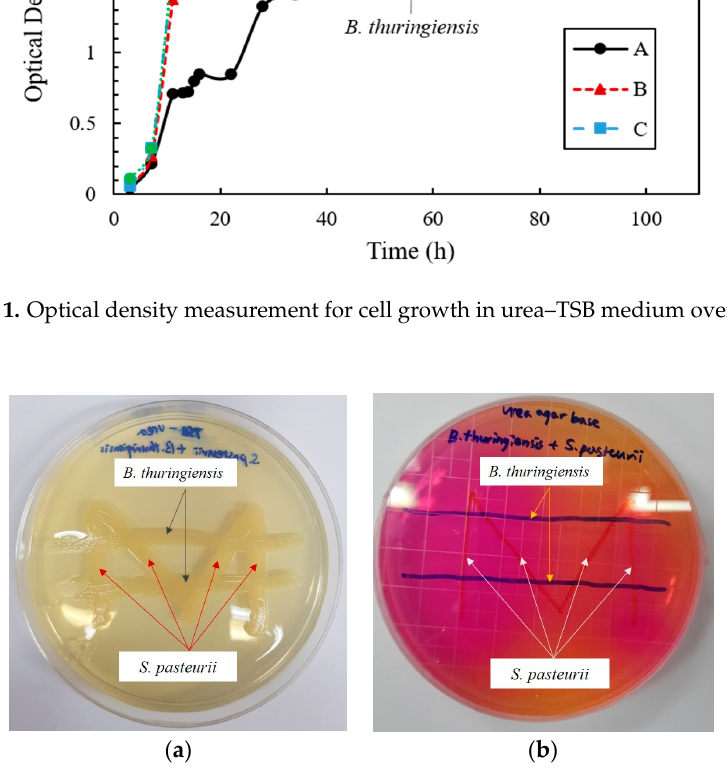
Figure 2. Bacteria growth images in: ( a ) urea–TSB solid medium; and ( b ) urea agar base medium.